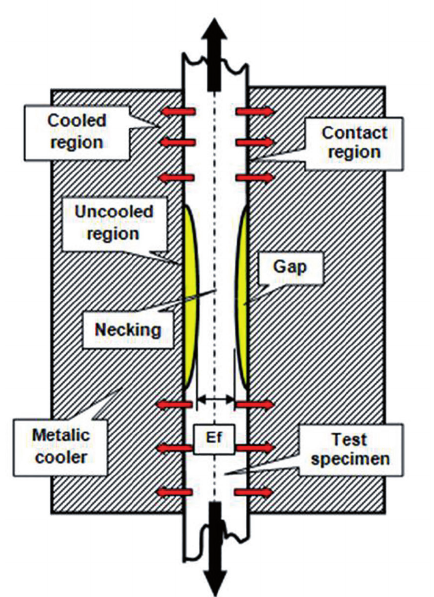
Figure 4: Necking and gap formation in hot stamping test using axial deformation.